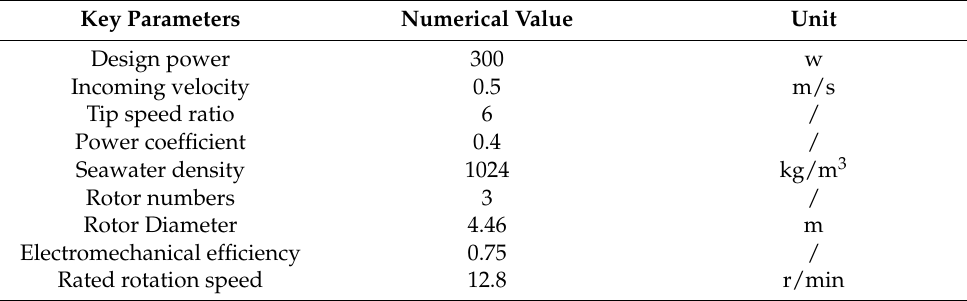
Table 1. HAMCT key